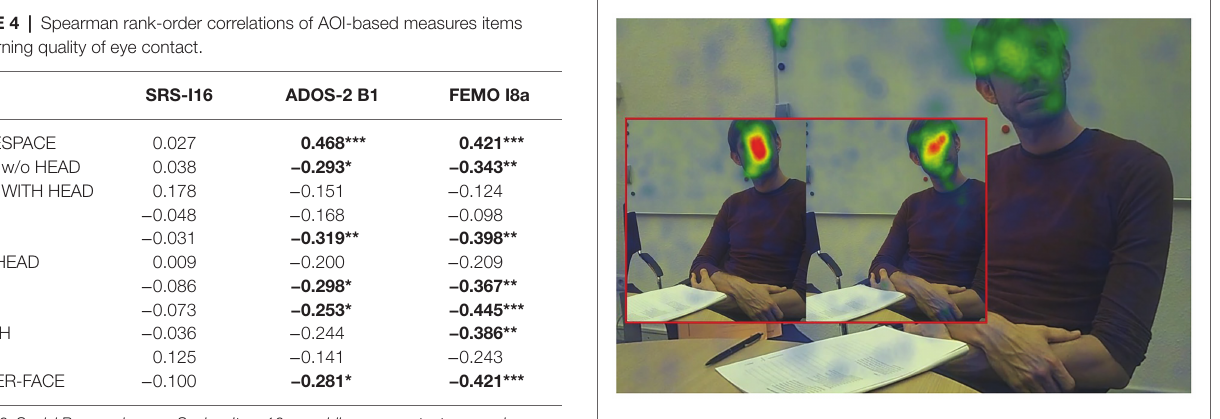
FIGURE 4 | Heat map of fixations for the three groups (red box left side: NTD; red box right side: non-ASC; big picture: ASC) for the first 2 min of the ADOS-2 “Conversation and Reporting”